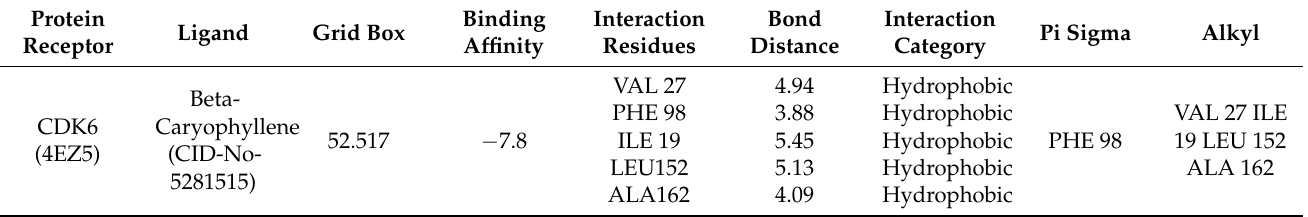
Figure 4. Beta ‐ Caryophyllene interacts with the inhibitor of Cyclin Dependent Kinase ‐ 1A, CDKN6 CDK6 with a stable binding energy around –7.8 at four possible binding sites. ( A ) 3D structure of Beta ‐ Caryophyllene CID: 5281515. ( B , C ) in silico interaction of BCP with CDK6 PDB ID: 4EZ5 and it shows effective binding and was calculated by the formation of bonds and docked amino acid residues. Table 1. BCP (CID: 5281515) in silico interaction with human cyclin ‐ dependent kinase ‐ 6 (inhibitor of CDKN1A).